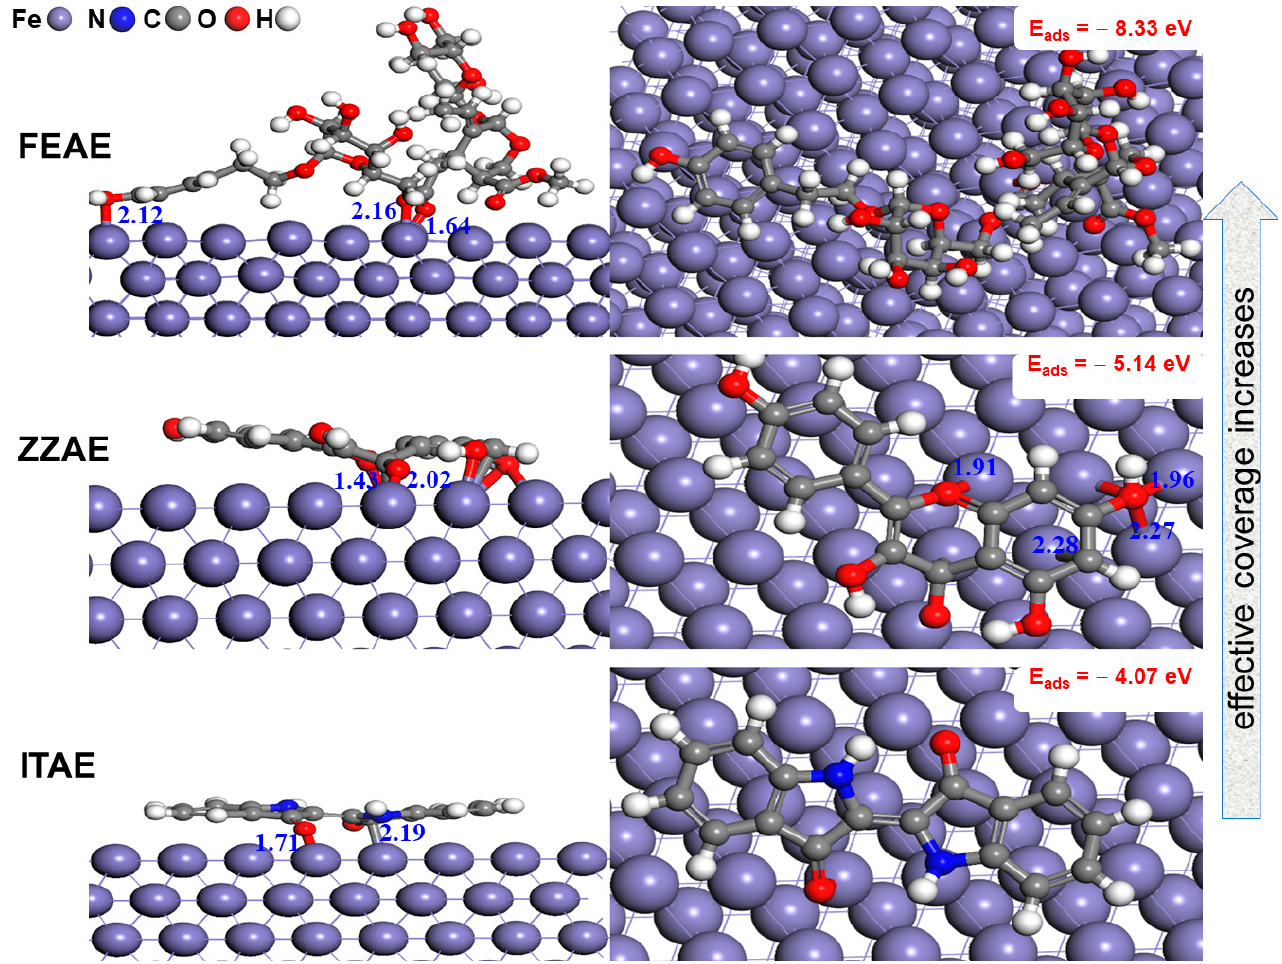
Figure 10. Most stable adsorption configurations modeled for three plant extracts on Fe(110) surface from DFTB calculation. The number on top each plot is the corresponding adsorption energy.